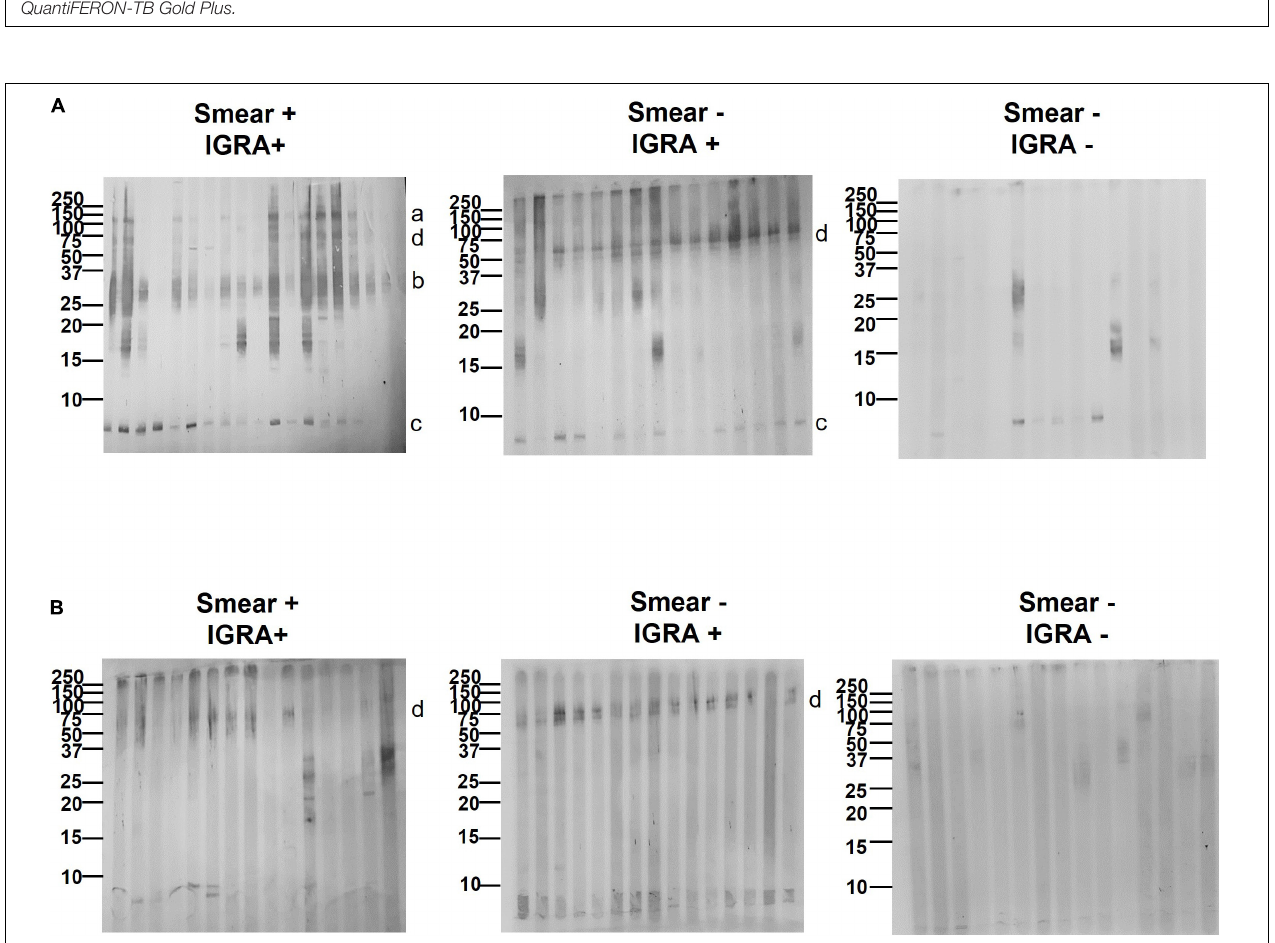
FIGURE 4 | Serological reactivity pattern of High Fe and Low Fe MEVs. Immunoblots of 15–18 representative serum samples from smear+, IGRA+ (TB), smear-, IGRA+ (Latent TB), and smear-, IGRA- (healthy) individuals against High Fe (A) and Low Fe (B) MEVs. MEVs were separated by SDS-PAGE and blotted with the serum samples. Membranes were further probed with an anti-human IgG secondary antibody conjugated with horseradish peroxidase (HRP) and developed with 3,3’,5,5’-Tetramethylbenzidin (TMB). Reactive MEV-associated protein bands a, b, c, and d are indicated next to the blots. For clarity, only a subset of standard marker bands (250–10 kDa, Bio-Rad, Hercules, CA, United States) is indicated.